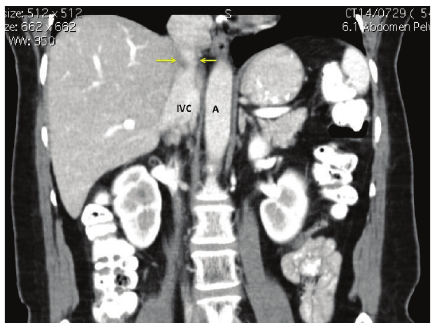
Figure 1: Axial CT images showing the IVC (V) receiving the LHV, MHV, and RHV. The solitary metastatic deposit ( ∗ ) is seen wedged between MHV and LHV and encroaches on the IVC. On axial cuts, the metastatic deposit is juxtaposed to, but does not appear to, involve the RHV.